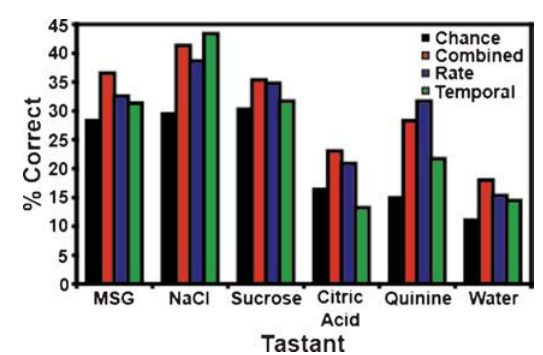
Figure 7. Tastant classifications for the reinforced lick data. This figure breaks down the tastant classification levels according to tastant category. In this case, both the combined and rate models correctly identify all stimuli above the weighted chance levels, while the temporal model fails to identify citric